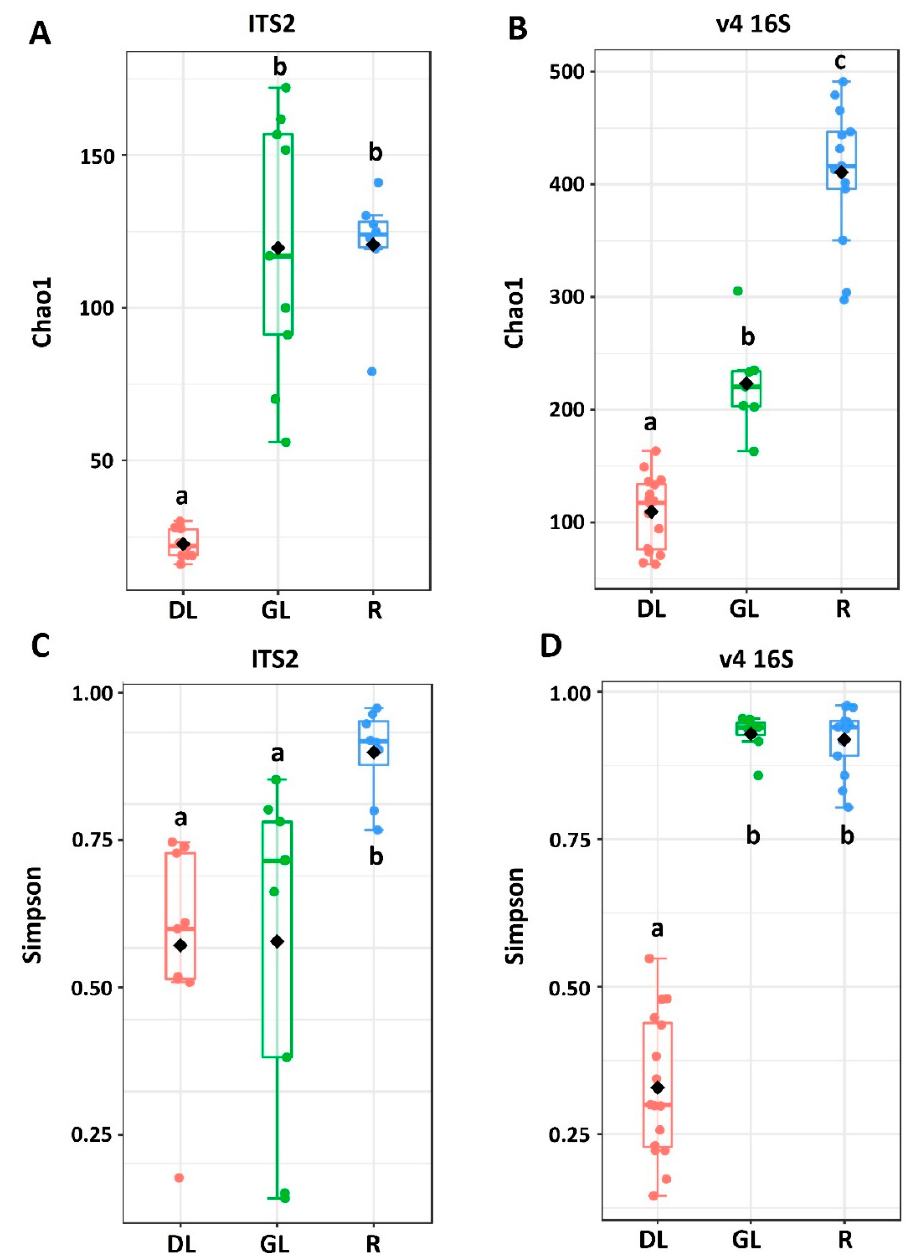
Figure 2. Richness (Chao1 index) ( A , B ) and diversity (Simpson index) ( C , D ) of the fungal ( A , C ) and bacterial ( B , D ) communities of winter rye plants a ff ected by the snow mold disease. Desiccated dead parts of leaves (DL), green parts of leaves (GL), and roots (R) were analyzed separately. Di ff erent letters on the bars indicate significant di ff erences between di ff erent sample types (Kruskal–Wallis tests at the operational taxonomic unit (OTU) level, p -value <